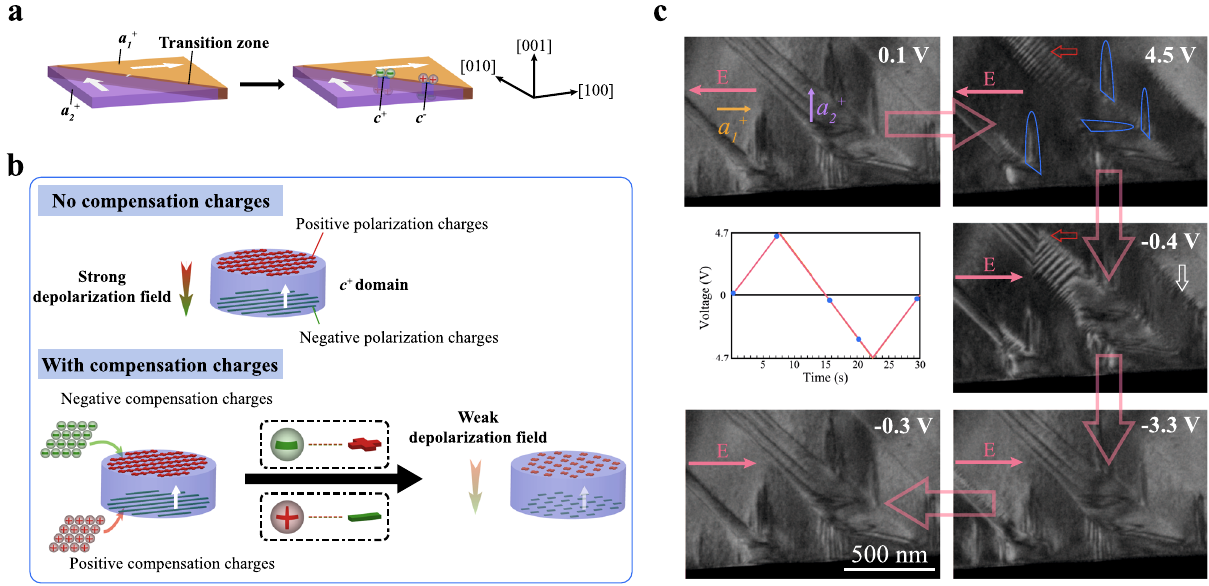
Fig. 4 Stabilization of c domains by compensation charges and the frozen behavior of c domains under electric loading. a The nucleation of c domains (the blue nuclei in the transition zone) from an original a 1 + / a 2 + domain wall. b c domains were stabilized by compensation charges on the surfaces. c A voltage – time curve of one electric cycle and a series of TEM images (extracted from Supplementary Movie 1) showing the responses of c domains to the electric fi eld stimulation. The c domains, which formed as a consequence of ferroelectric degradation, did not reverse with the application of the cyclic in-plane electric loading. The small red hollow arrows denote the intermediate ferroelastic domains formed during multi-switching in an a 2 + domain. The small white hollow arrow denotes the zipper-shaped domain wall formed during the switching process. The blue lines mark the contours of some c